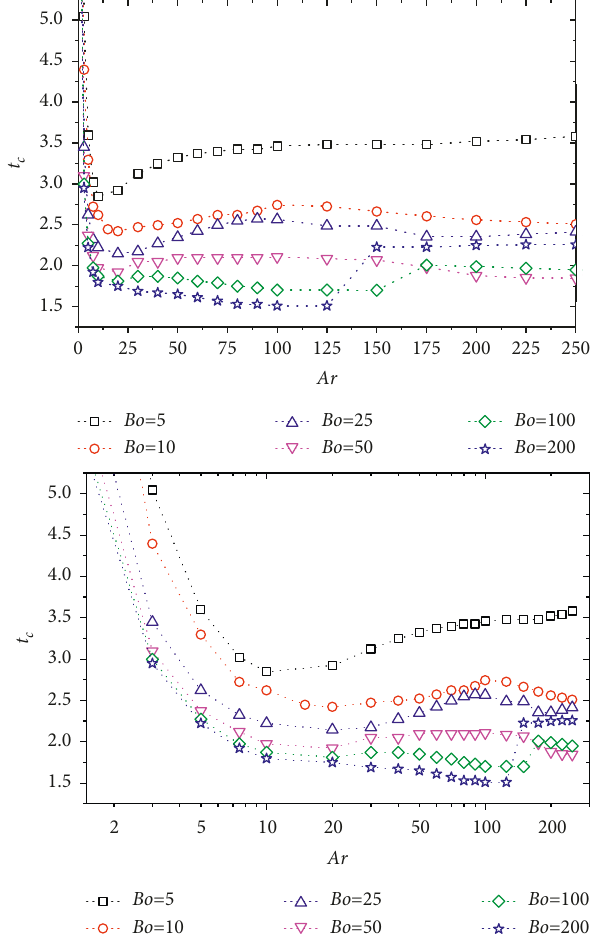
Figure 9: Effect of Ar on coalescence time at different